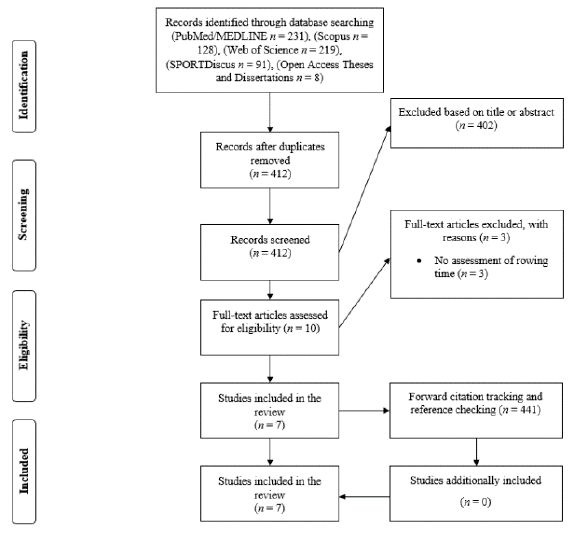
Figure 1. Flow diagram of the search process.